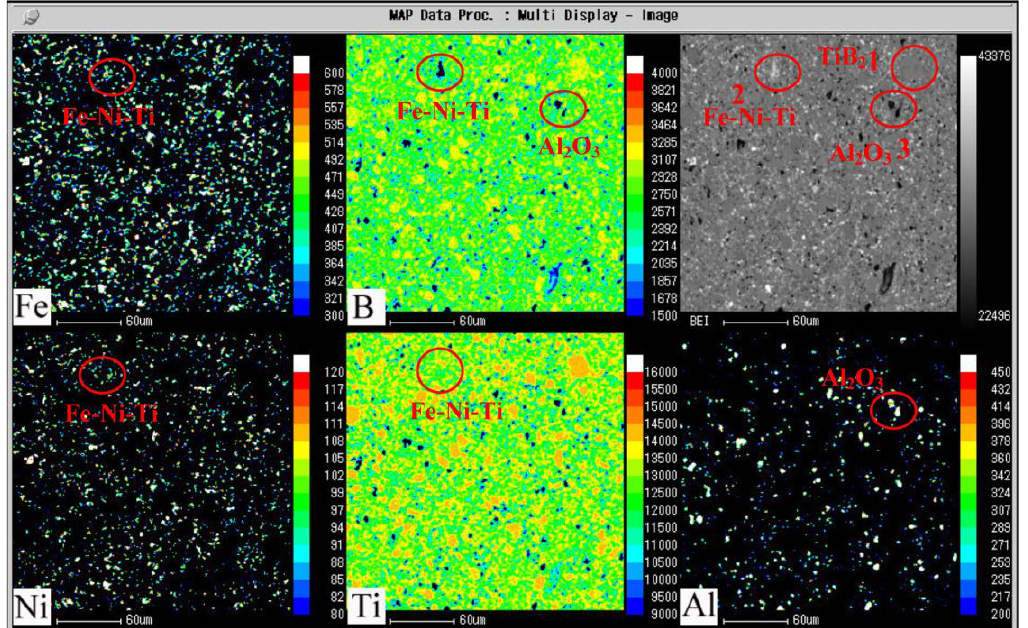
Figure 6. X-ray dot mapping of major elements for the TiB 2 –5 wt% (Fe–Ni–Ti–Al) specimen sintered at 1300 °C and held for 5